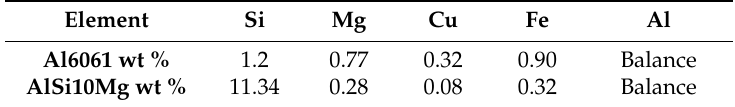
Table 3. Energy X-ray dispersive spectroscopy (EDS) analysis of the Al6061 and AlSi10Mg powders’ chemical composition.